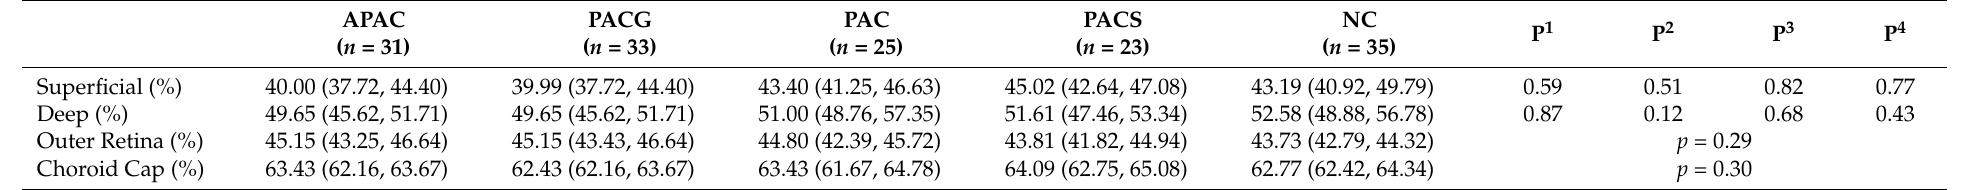
Table 4. Macular whole image vessel density (wiVD).